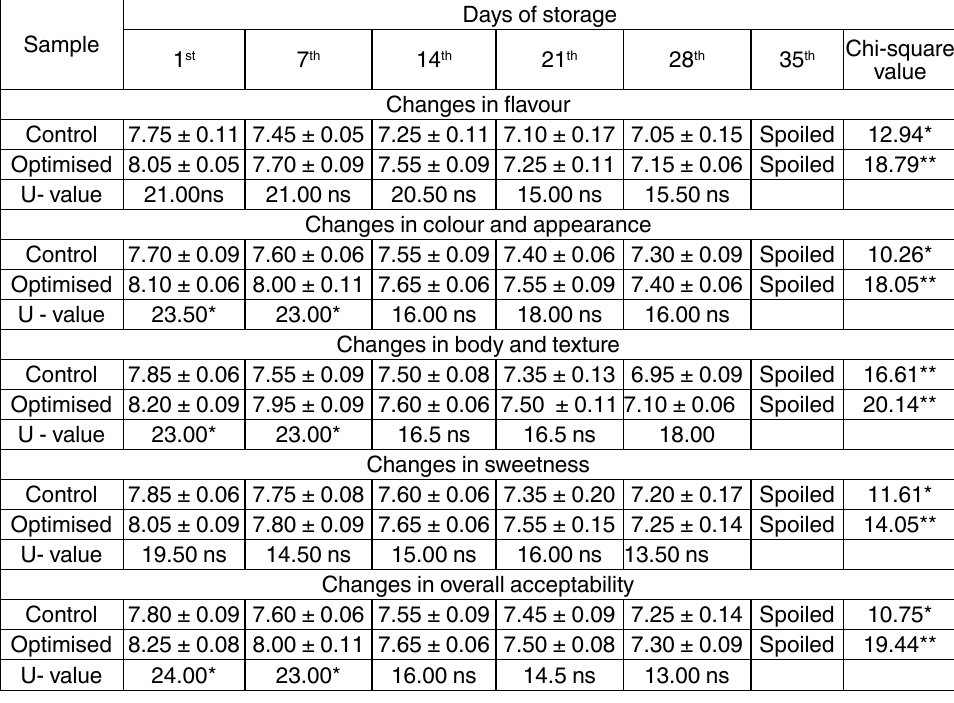
table 3 . Effect of refrigerated storage on sensory attributes of lutein incorporated calcium and fortified Shrikhand vitamin D 3